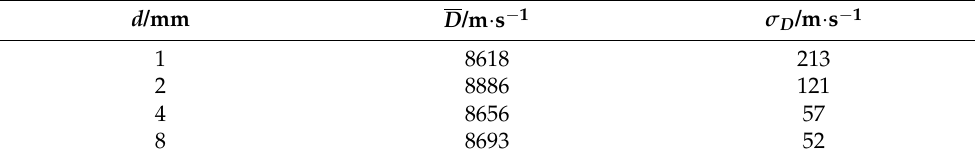
Table 10. Average value and standard deviation of previous detonation velocity